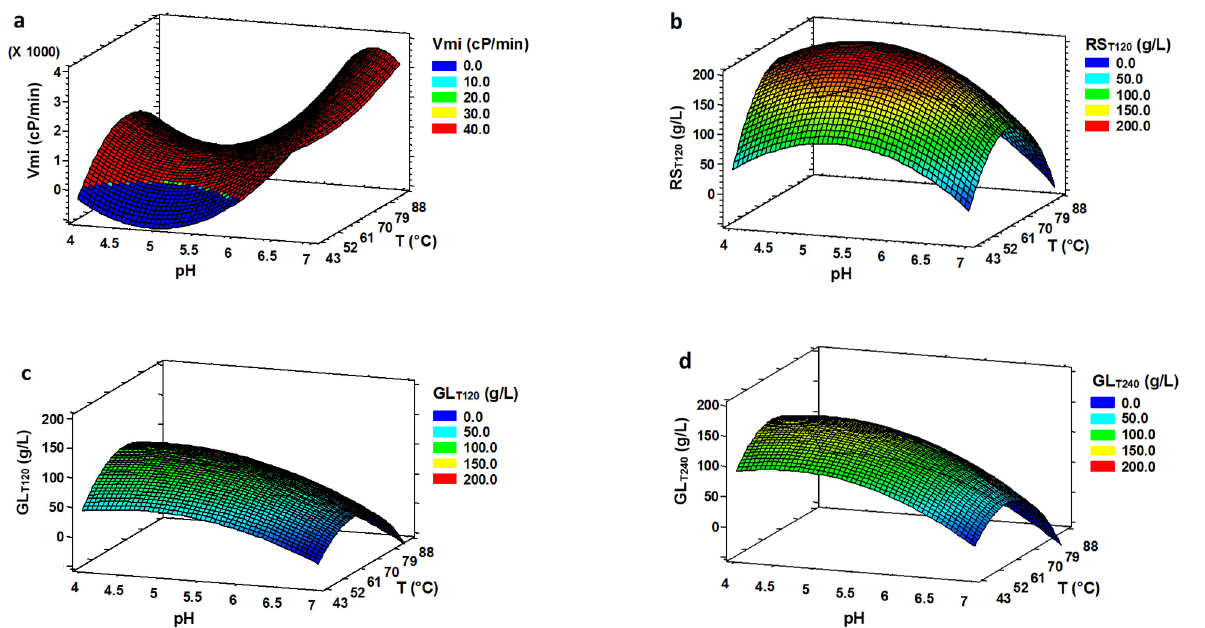
Figure 3. Response surface plots for simultaneous hydrolysis phase as function of temperature and pH for ( a ) slope of viscosity curve (V mi ), ( b ) theoretical RS concentration at 120 min (RS T120 ), ( c ) theoretical glucose concentration at 120 min (GL T120 ) and ( d ) theoretical glucose concentration at 240 min (GL T240 ).